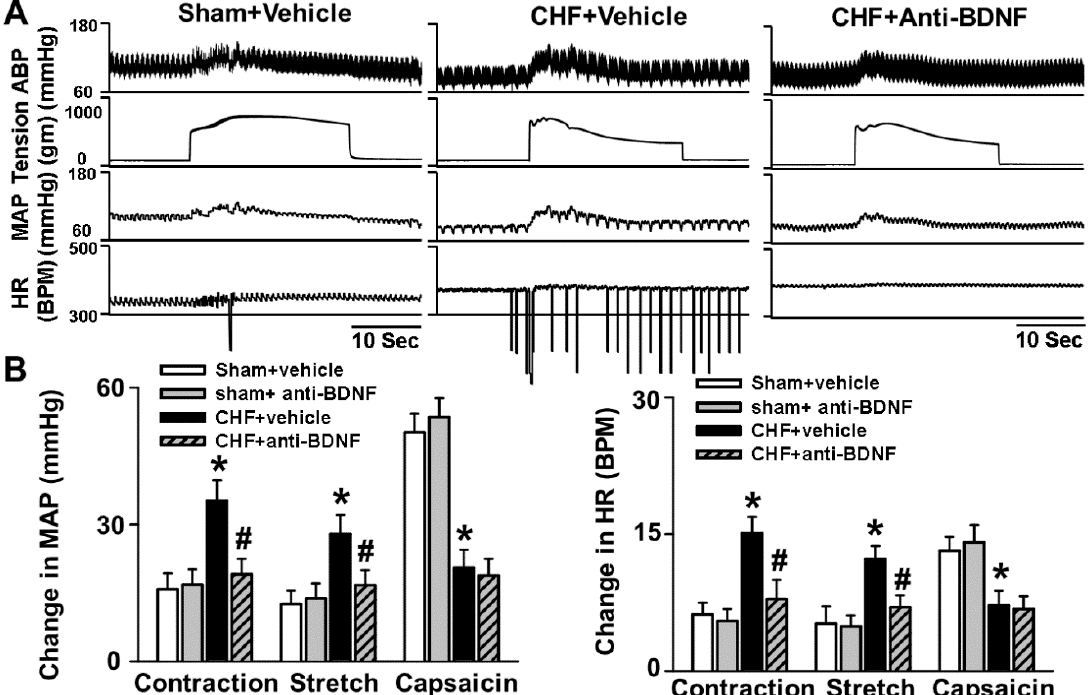
Figure 3. The effect of 7-day epidural infusion of anti-BDNF (1.0 µ g/ µ L/h, 1) to lumbar DRGs on the pressor and tachycardia responses to static contraction, passive stretch or hindlimb arterial infusion capsaicin (1.0 µ g/kg, 0.2 mL) in sham and CHF rats. ( A ) The representative figures showed the pressor and tachycardia responses to muscle static contraction in Sham + Vehicle, CHF + Vehicle and CHF + Anti-BDNF rats respectively. ( B ) the summary data showed the pressor and tachycardia responses to static contraction, passive stretch or hindlimb arterial infusion capsaicin in sham and CHF rats with and without anti-BDNF treatment. Mean ± SE. n = 6–8/each group. * p < 0.05 vs. sham + Vehicle, # p < 0.05 vs. CHF + vehicle group. Table 2. Tension-time indexes for either static contraction or passive stretch in Sham + Vehicle, Sham + Anti-BDNF, CHF + Vehicle and CHF + Anti-BDNF rats.